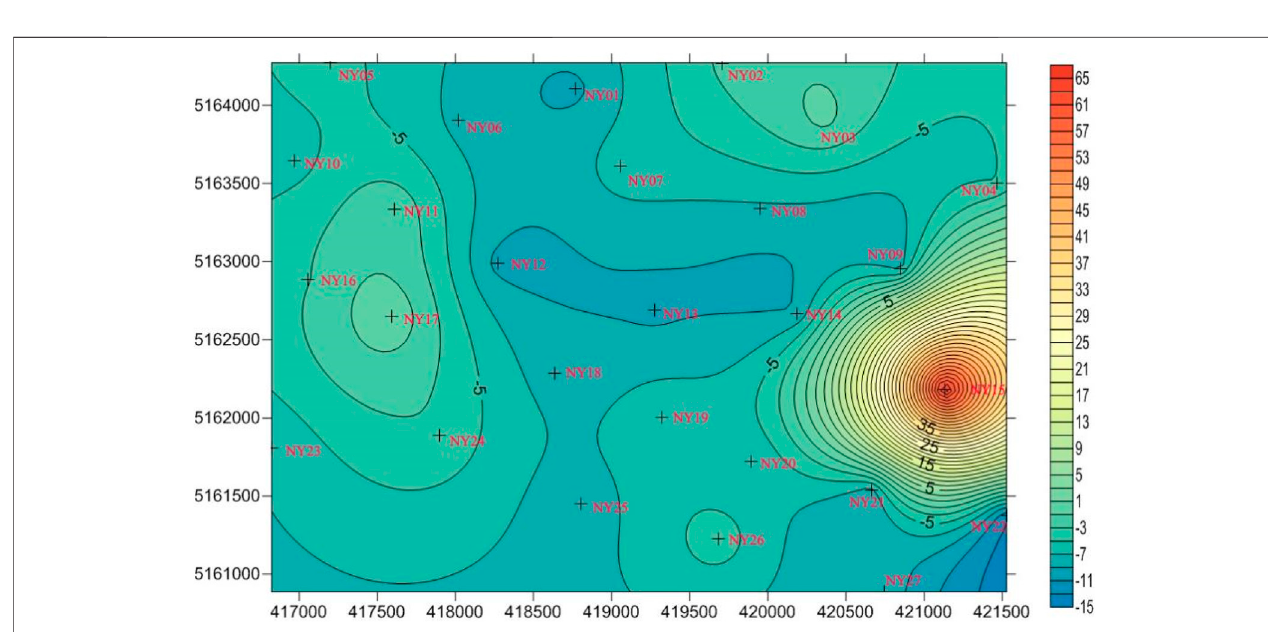
FIGURE 5 | Surface vertical displacement fi eld measured based on vertical position change from November 2017 to April 2018 1 .